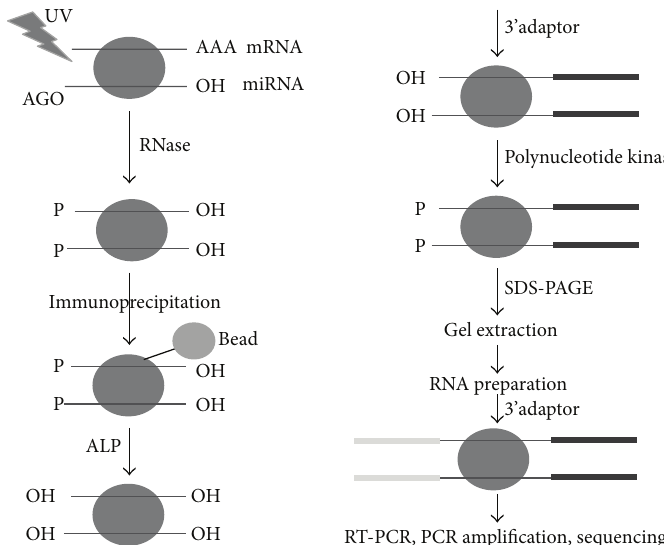
Figure 4: Scheme of Argonaute high-throughput sequencing of RNAs by cross linking and immunoprecipitation. RNA and protein are cross linked by UV and then RNA is digested by RNase, a treatment which is finally immunoprecipated. 5 󸀠 ends are dephosphorylated and 3 󸀠 ends are adapter ligated followed by phosphate addition at 5 󸀠 ends. The complexes of RNA and protein are separated by SDS-PAGE and RNA are amplified after 5 󸀠 -adaptor ligation. These amplified products will be sequenced by next generation sequencers and finally computational approaches will help identify the miRNA target.